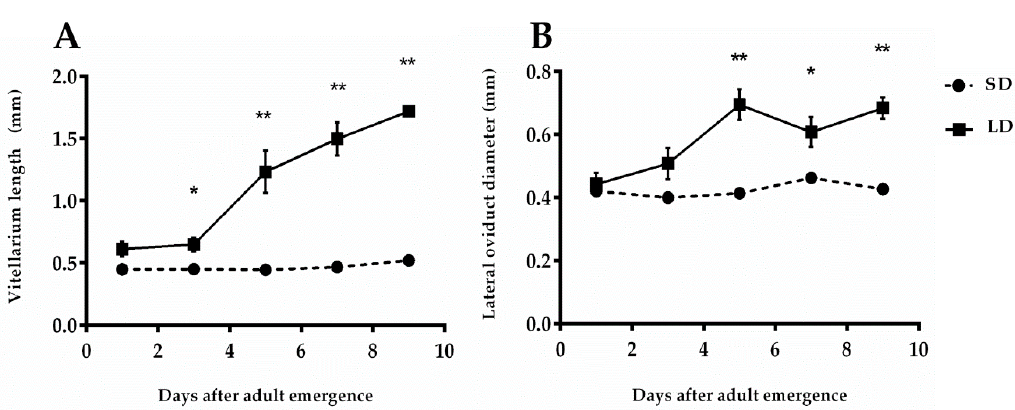
Figure 2. Differences in the development of different parts of ovaries in prediapause (LD) and preoviposition (SD) females of R. pedestris . The horizontal lines indicate the experimental days after adult emergence, whereas perpendicular lines show the measurements of vitellarium length ( A ) and lateral oviduct diameter ( B ). Each point represents the mean ± SEM for 10 individuals. Asterisks indicate significant differences between the independent samples according to t -test,* p < 0.05, ** p < 0.01.